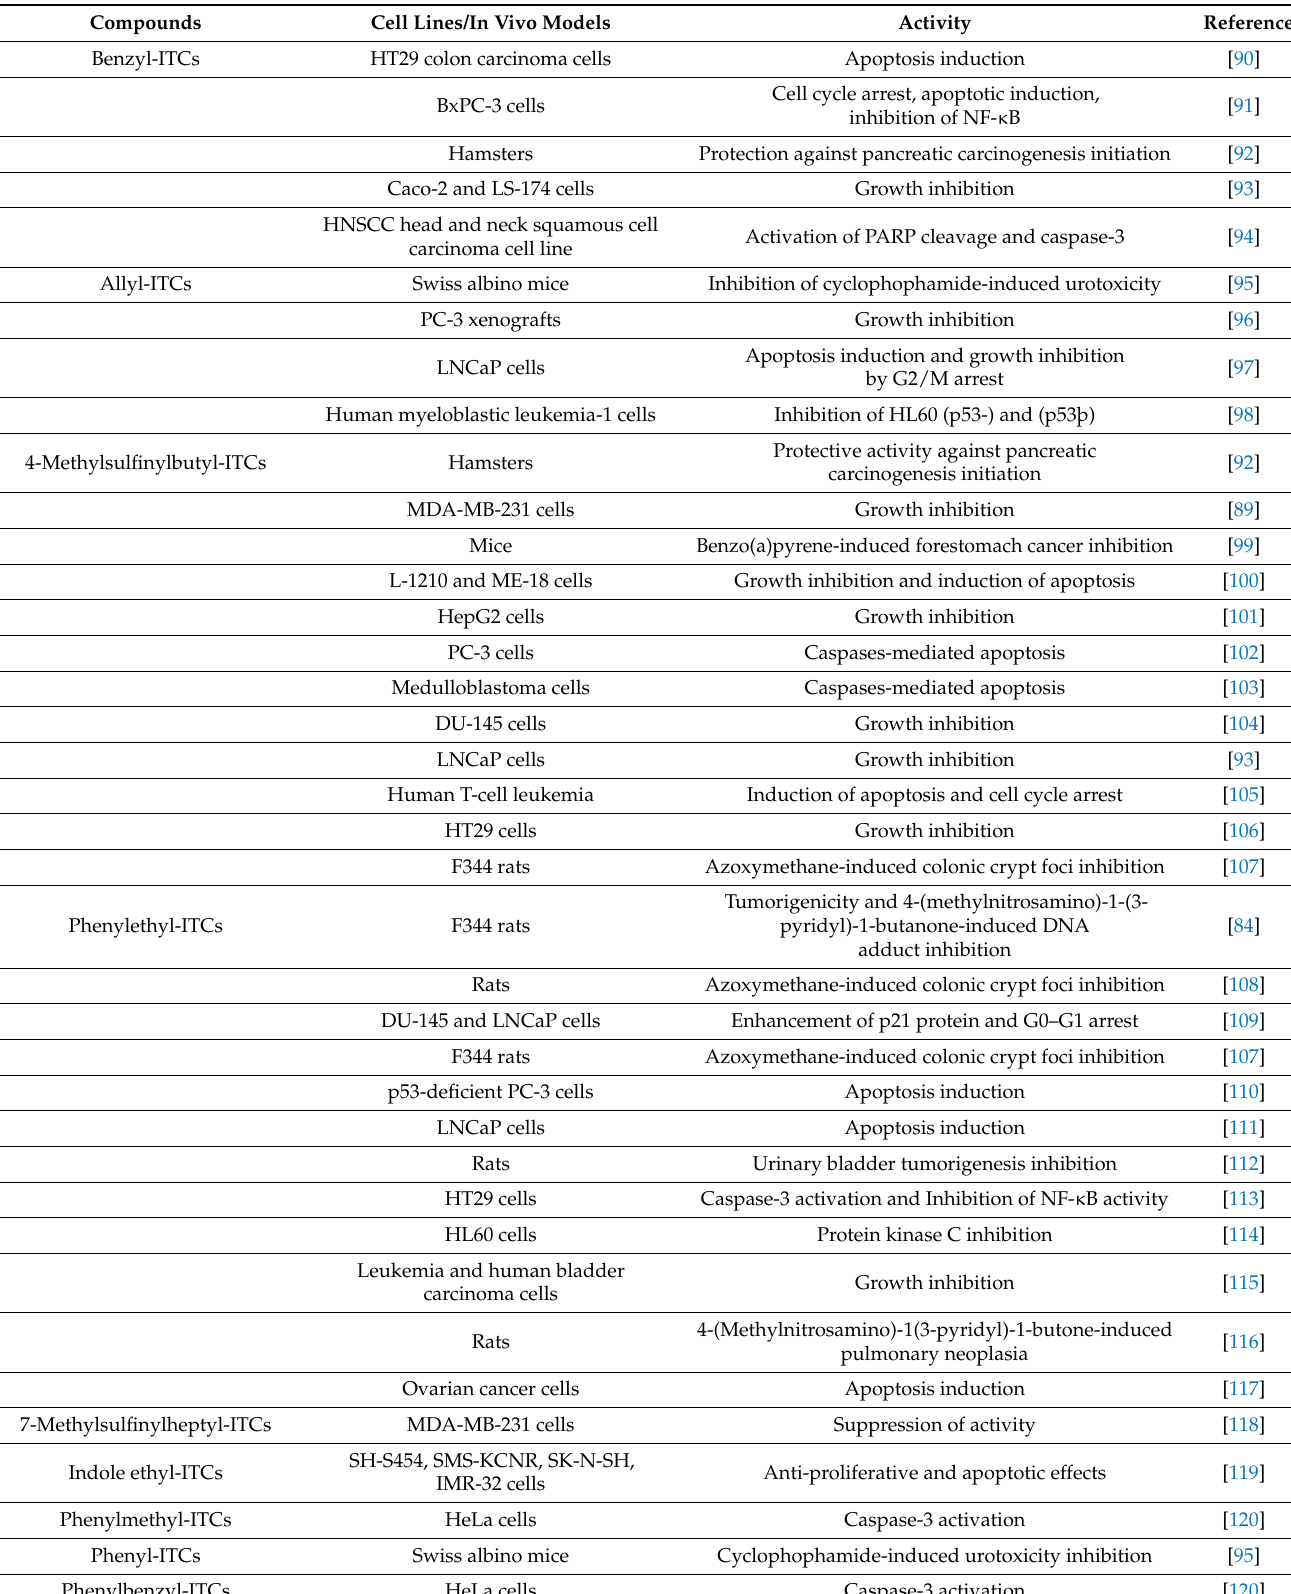
Table 3. Antiproliferative activity of GSLs hydrolyzed compounds (isothiocyanates,